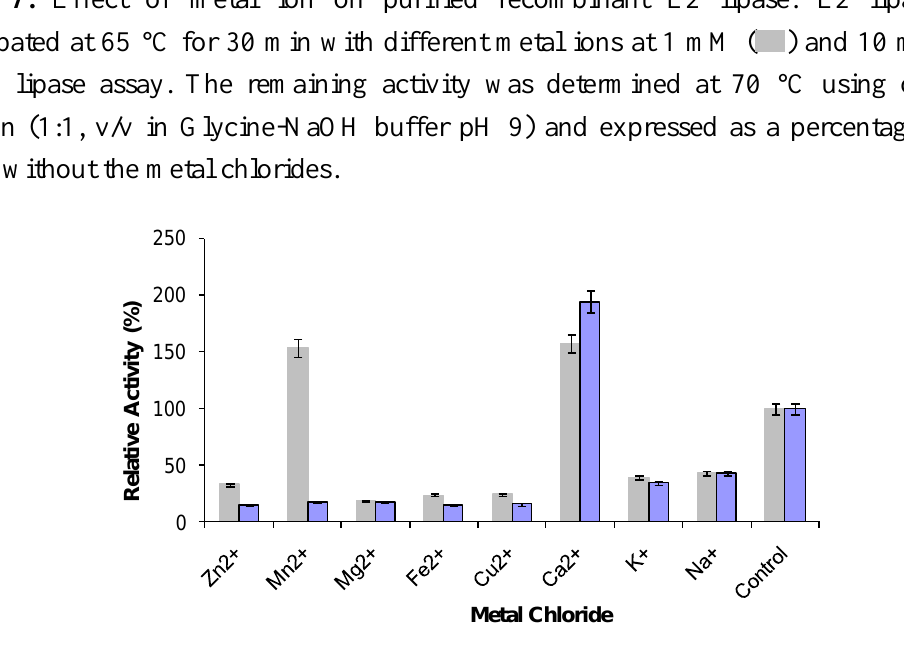
Figure 8. Influence of effectors on purified recombinant L2 lipase activity. The L2 lipase was incubated with 1 mm and 5 mm of effectors (except Pepstatin A) at 65 °C for 30 min prior to lipase assay at standard